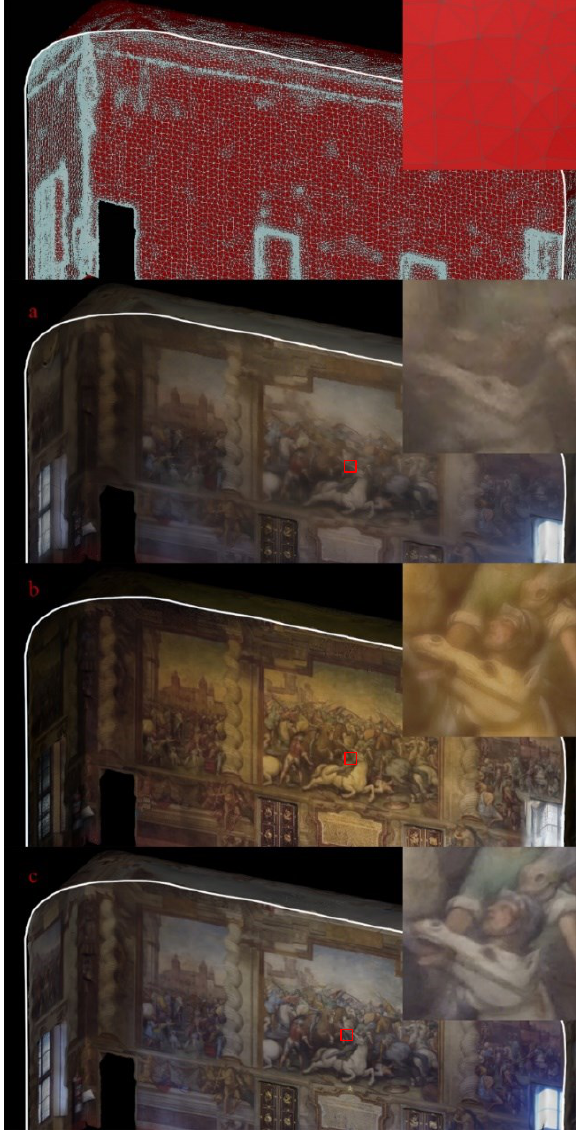
Figure 14. Triangulated surface generated by ZEB point clouds with associated photogrammetric texture. top , ZEB triangulated mesh in wireframe view. Texture from: a , ZEBcam frames; b , Sony ILCE images; c , steadicamera frames. For each textured mesh model, a zoomed view of about